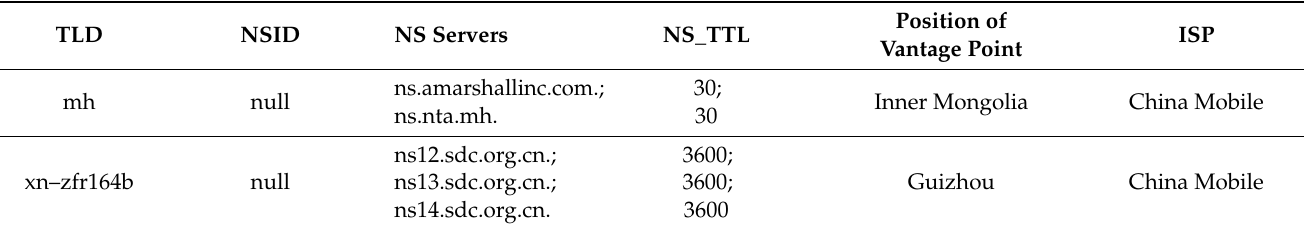
Table 5. Examples of hijacking domain